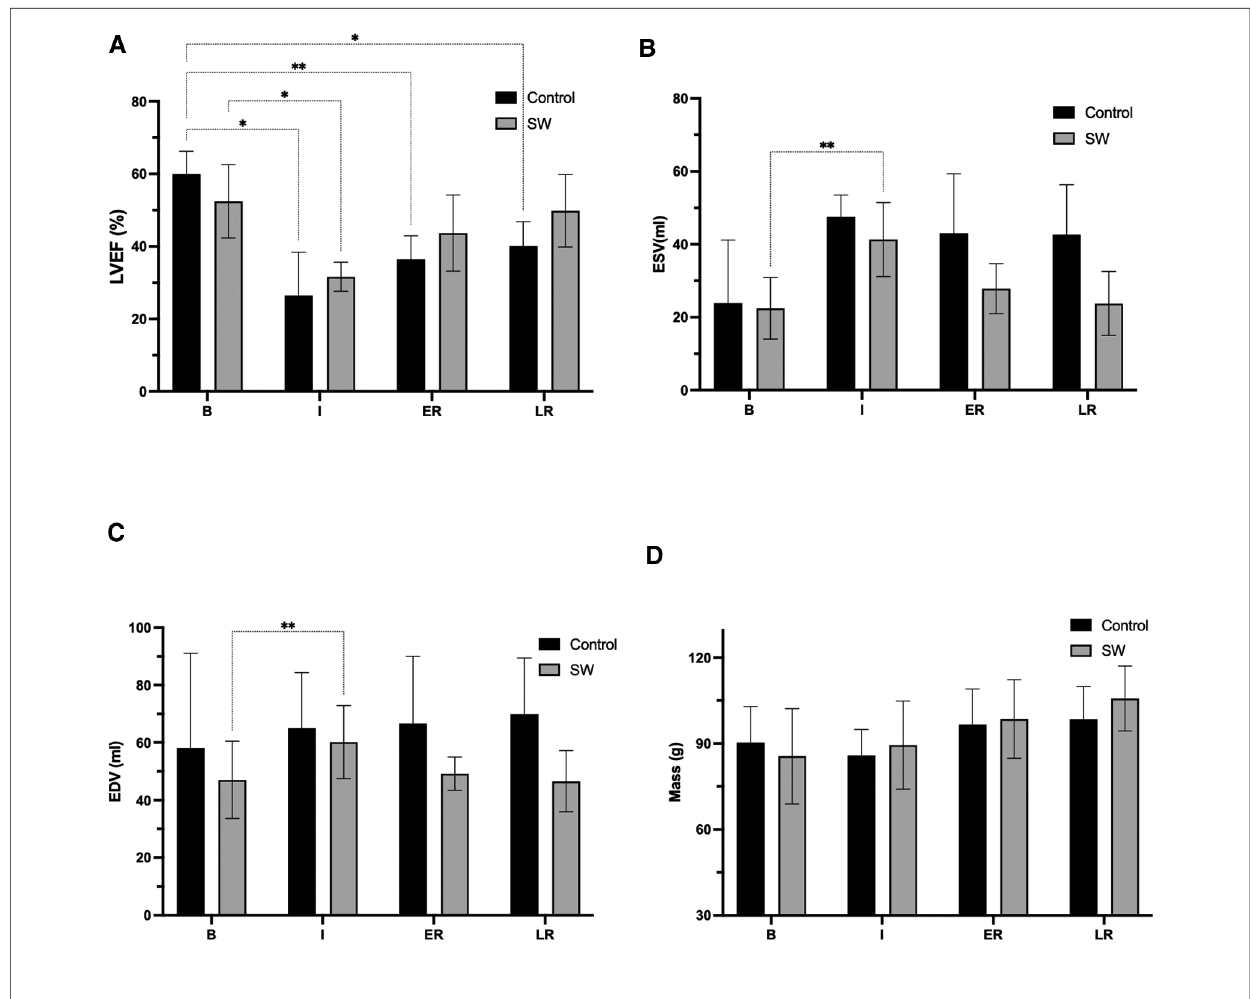
FIGURE 4 Global function parameters (LVEF ( A ) ESV ( B ), EDV ( C ), and LV mass ( D )) changes at the four stages of the experimental ischemia-reperfusion protocol: Baseline ( B ), Ischemia ( I ), Early (ER) and Late Reperfusion (LR)), in controls (black) and SW therapy group (grey). (*: p <0.05, **: p <0.01). LVEF: left ventricle ejection fraction, ESV: end-systolic volume, EDV: end-diastolic volume, LV: left ventricle. All post-hoc comparisons are provided in Supplementary Material Section, Table S2